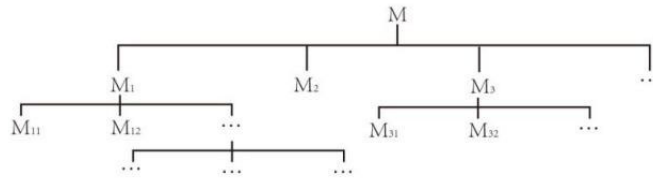
Figure 6. Implied system analysis.